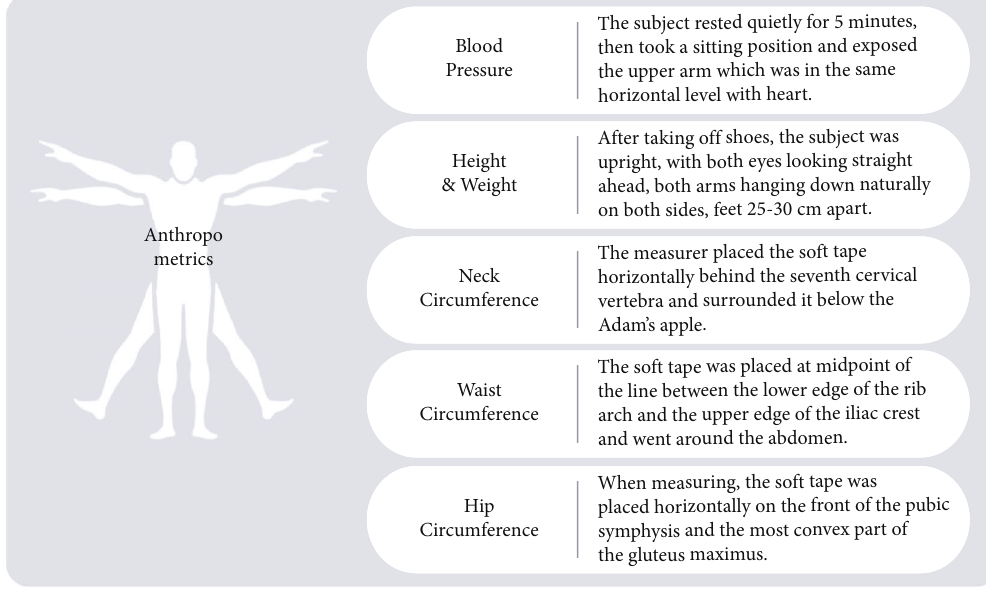
Figure 2: Standard anthropometric measurement methods.